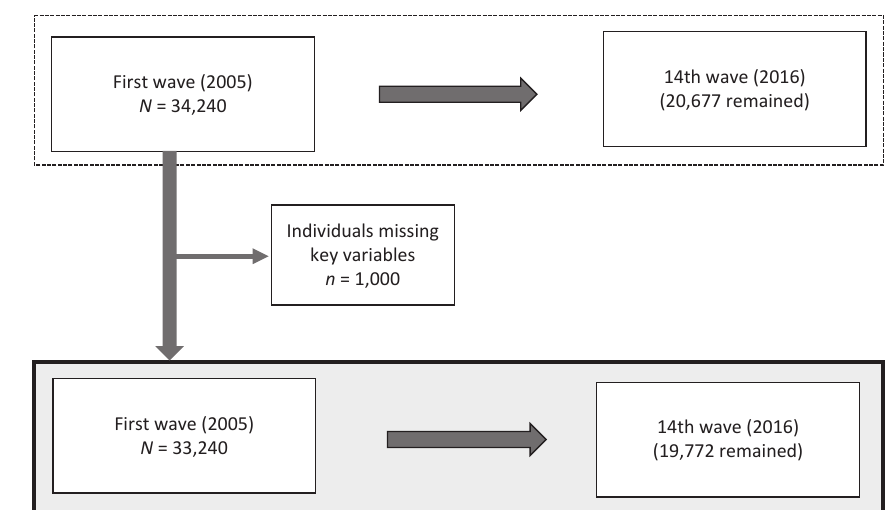
Figure 1. Structure of the sample used in this